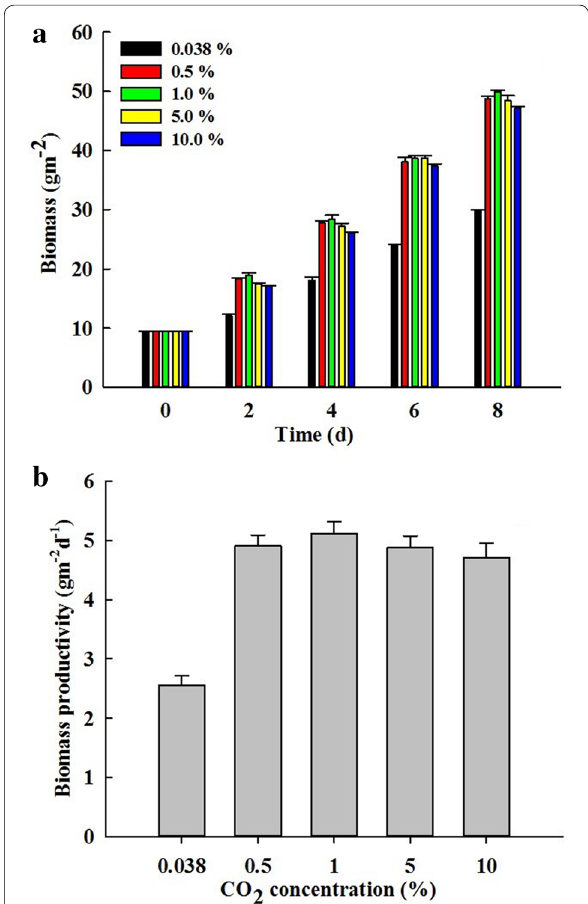
Fig. 3 Effect of CO 2 concentration on growth of B. braunii SAG807‑1 under attached cultivation. The biomass densities after different days cultivations ( a ) and the average biomass productivity of 8 days cultivations ( b ) at the CO 2 concentrations of 0.038, 0.5, 1.0, 5.0 and 10.0%. Data are means standard deviations of three replicates ±